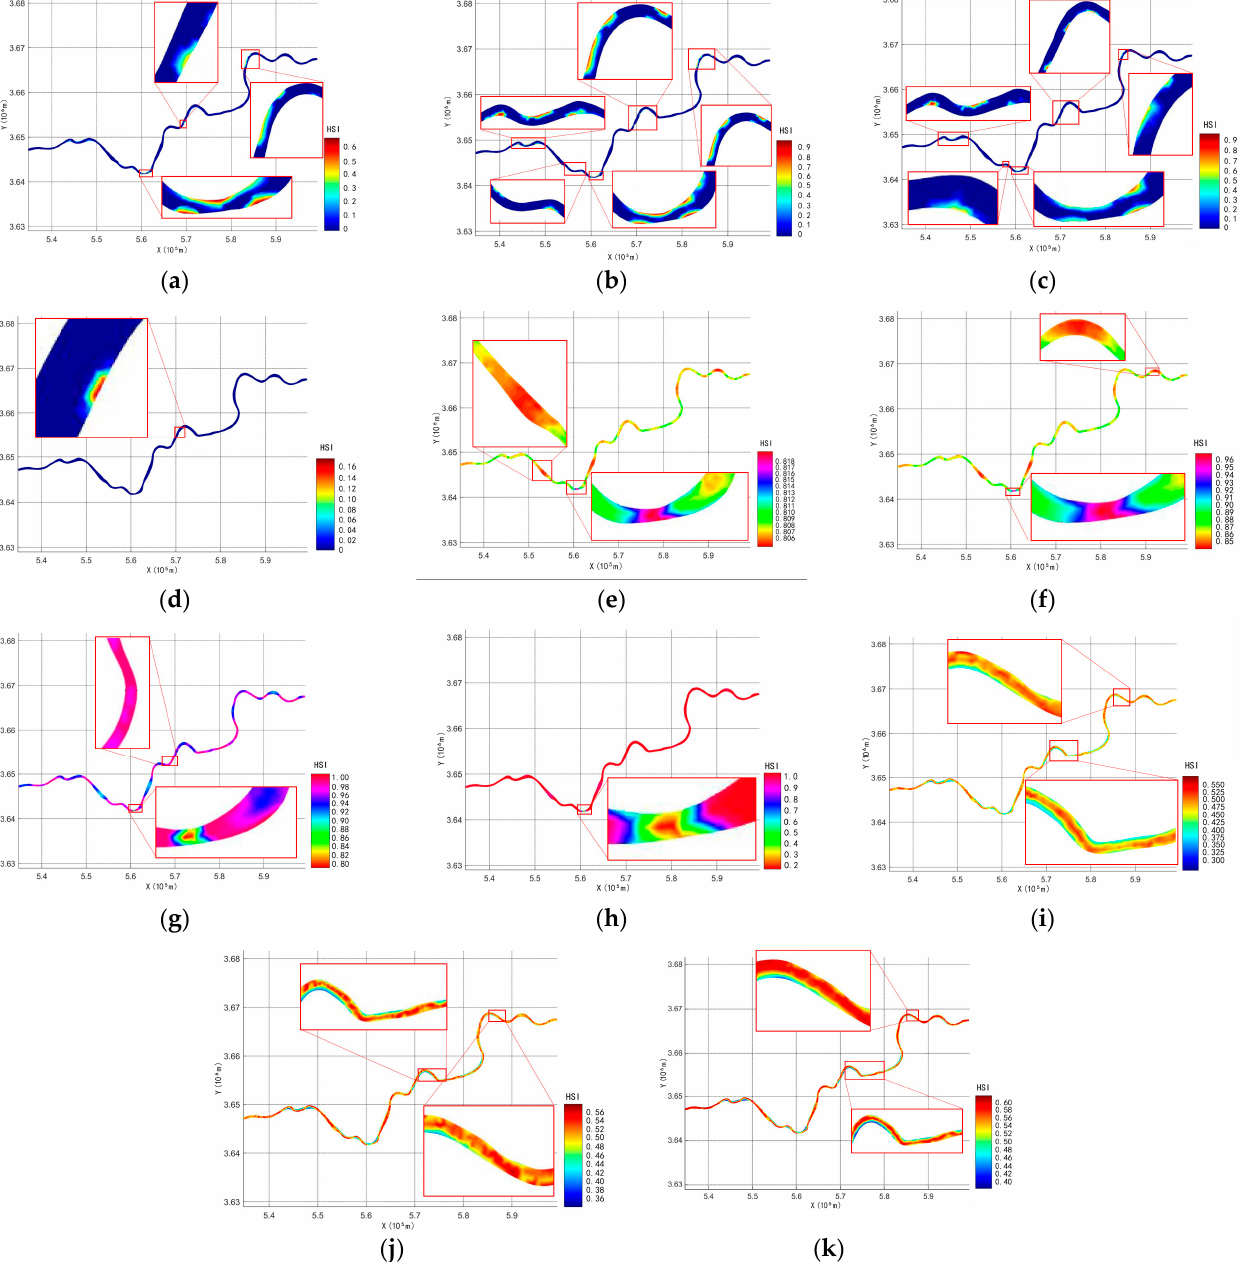
Figure 4. Distribution of Parabramis pekinensis HSI in different periods: ( a ) spawning (100 m 3 /s); ( b ) spawning (500 m 3 /s); ( c ) spawning (1000 m 3 /s); ( d ) spawning (3000 m 3 /s); ( e ) feeding (100 m 3 /s); ( f ) feeding (1000 m 3 /s); ( g ) feeding (3000 m 3 /s); ( h ) feeding (5000 m 3 /s); ( i ) overwintering (100 m 3 /s); ( j ) overwintering (500 m 3 /s); ( k ) overwintering (1000 m 3 /s).